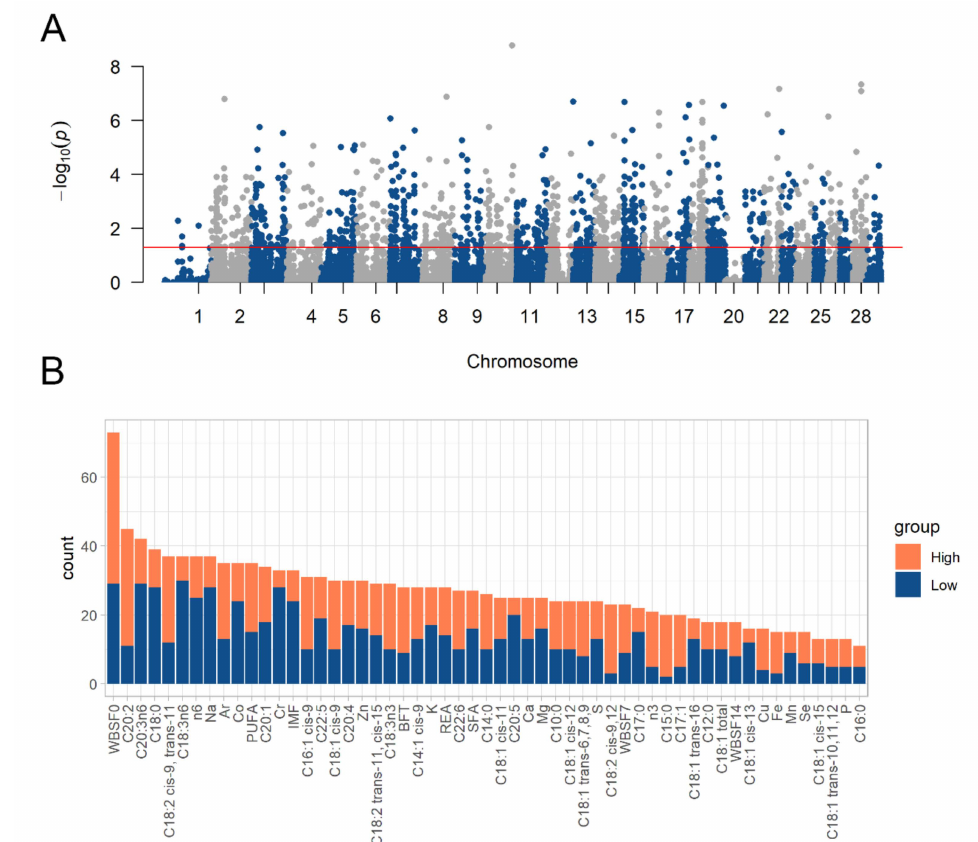
Figure 2. Differential allele-specific expression analysis results. ( A ) Manhattan Plot with all DASE analysis results. The points above the red line were the significant DASE SNPs (FDR ≤ 0.05). ( B ) Number of DASE SNPs per trait. The colors correspond to the sample group that presented more allelic imbalance: Orange color represent the number of DASE SNPs with more ASE in the high group (positive Log2FoldChange values), and the blue color represents the ones with more ASE in the low group (negative Log2FoldChange